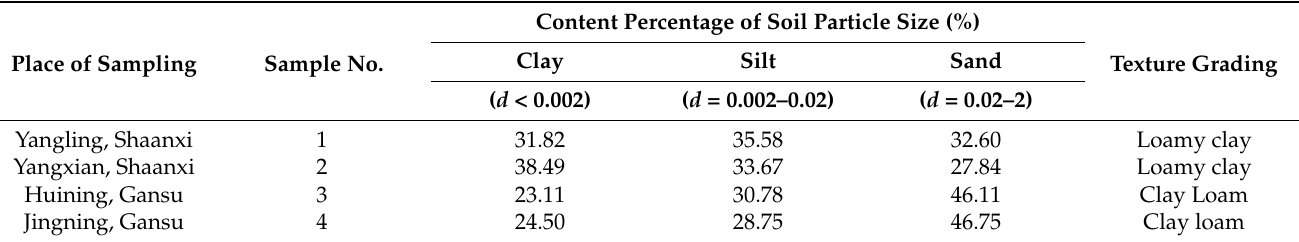
Note: d represents the soil particle diameter for all sizes (unit: mm).